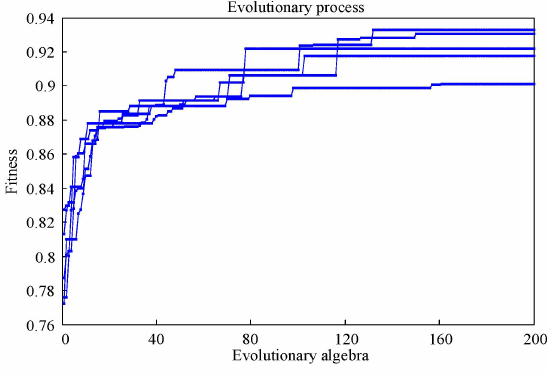
Figure 15. Convergence procedure of the SGA under fault scenario 2.